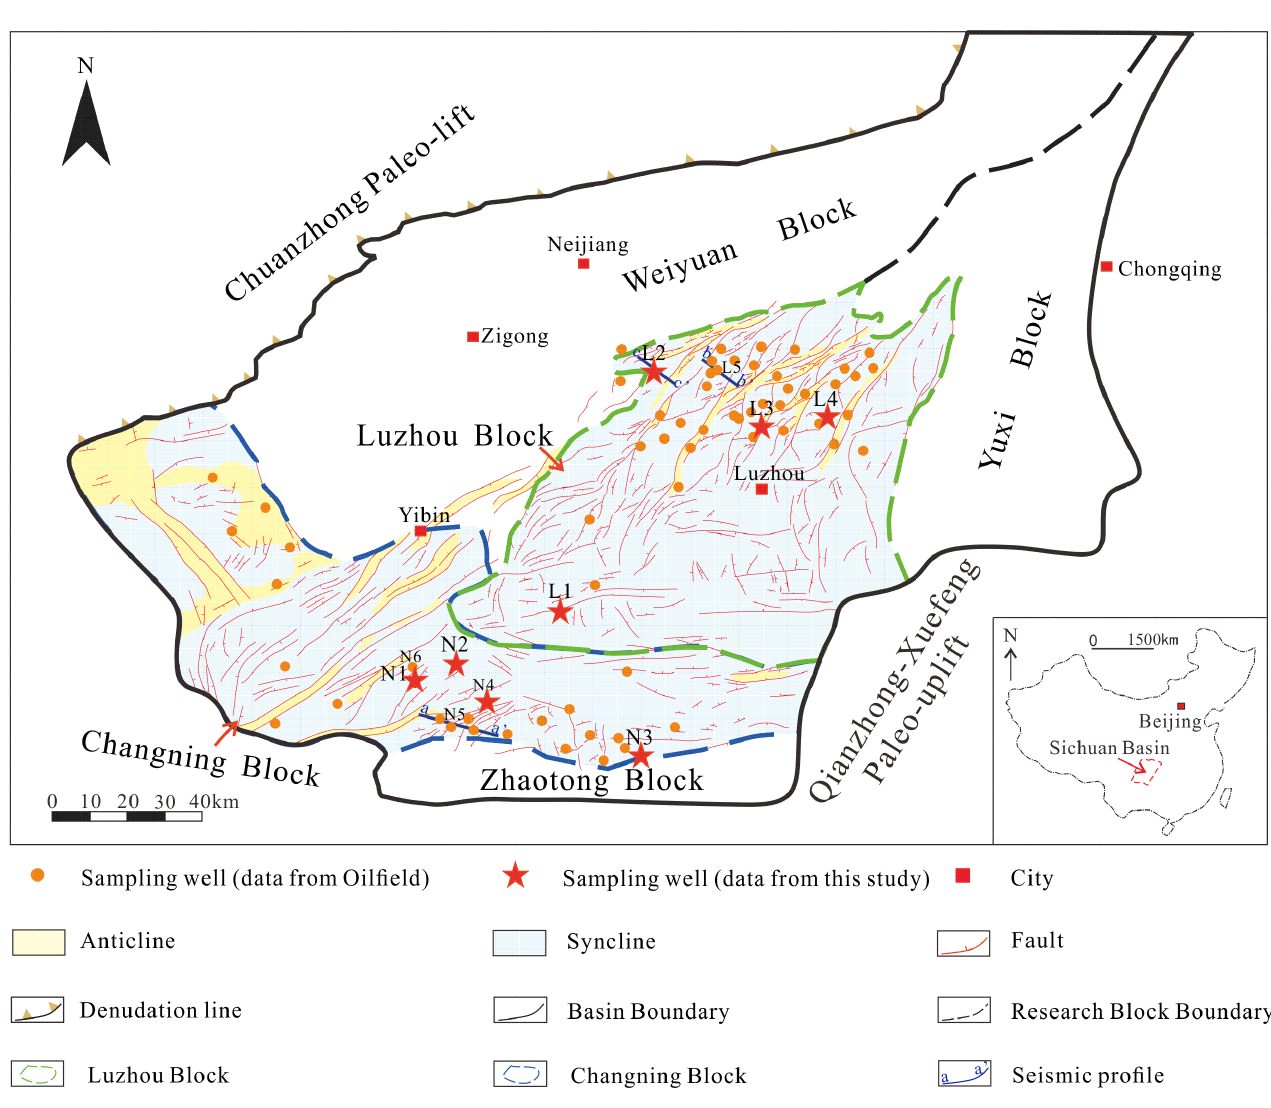
Figure 1. Map showing tectonic sub-units of the Southern Sichuan Basin. The green and blue rectangular dotted lines represent the Changning block and Luzhou block, respectively (modified after [22,23]).